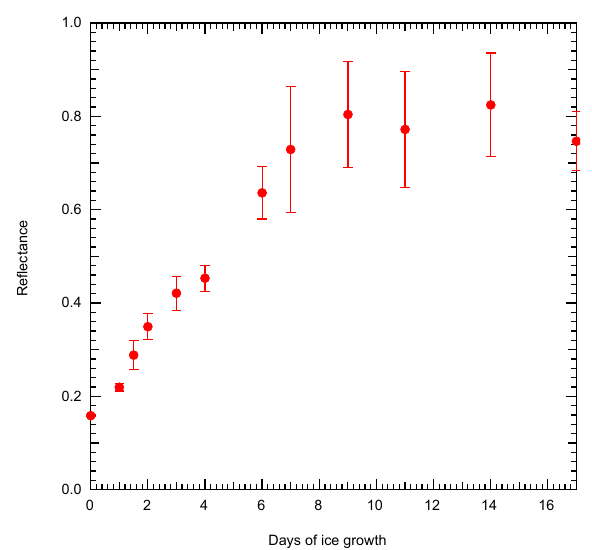
Figure 3. Reflectance of sea ice during ice growth and the day-to- day reflectance stability of the potentially optically thick ice (day 10